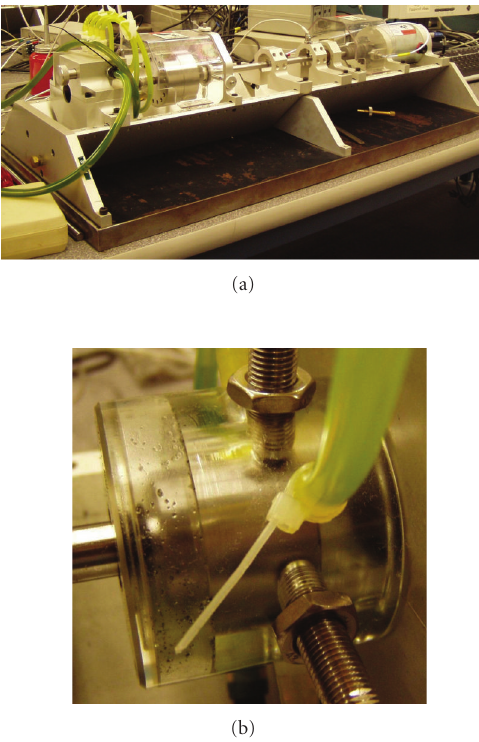
Figure 12: Experimental setup (a) with fluid bearing on the left and variable speed motor on the right, (b) close-up of fluid bearing showing supply lines and proximity probes.